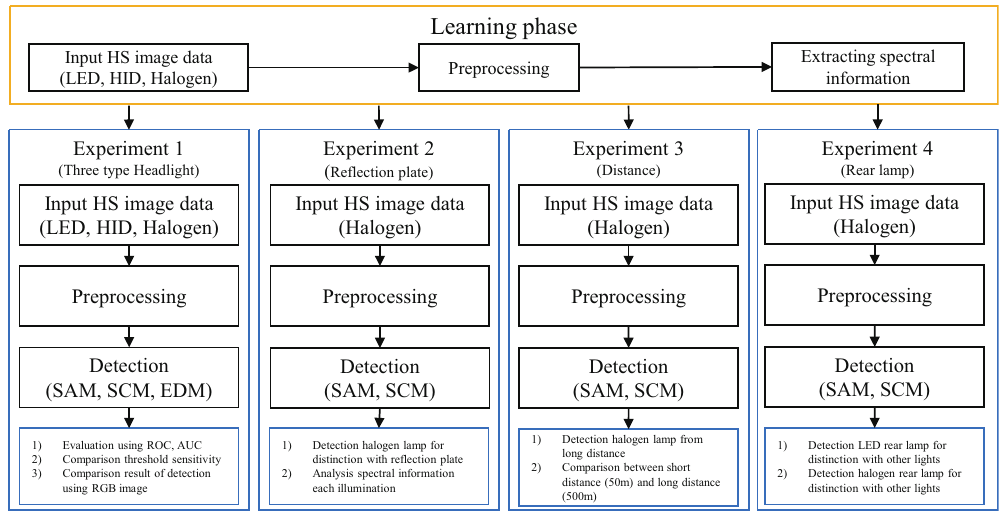
Figure 2. Block diagram of processing to detect vehicle headlights and a comparison of each